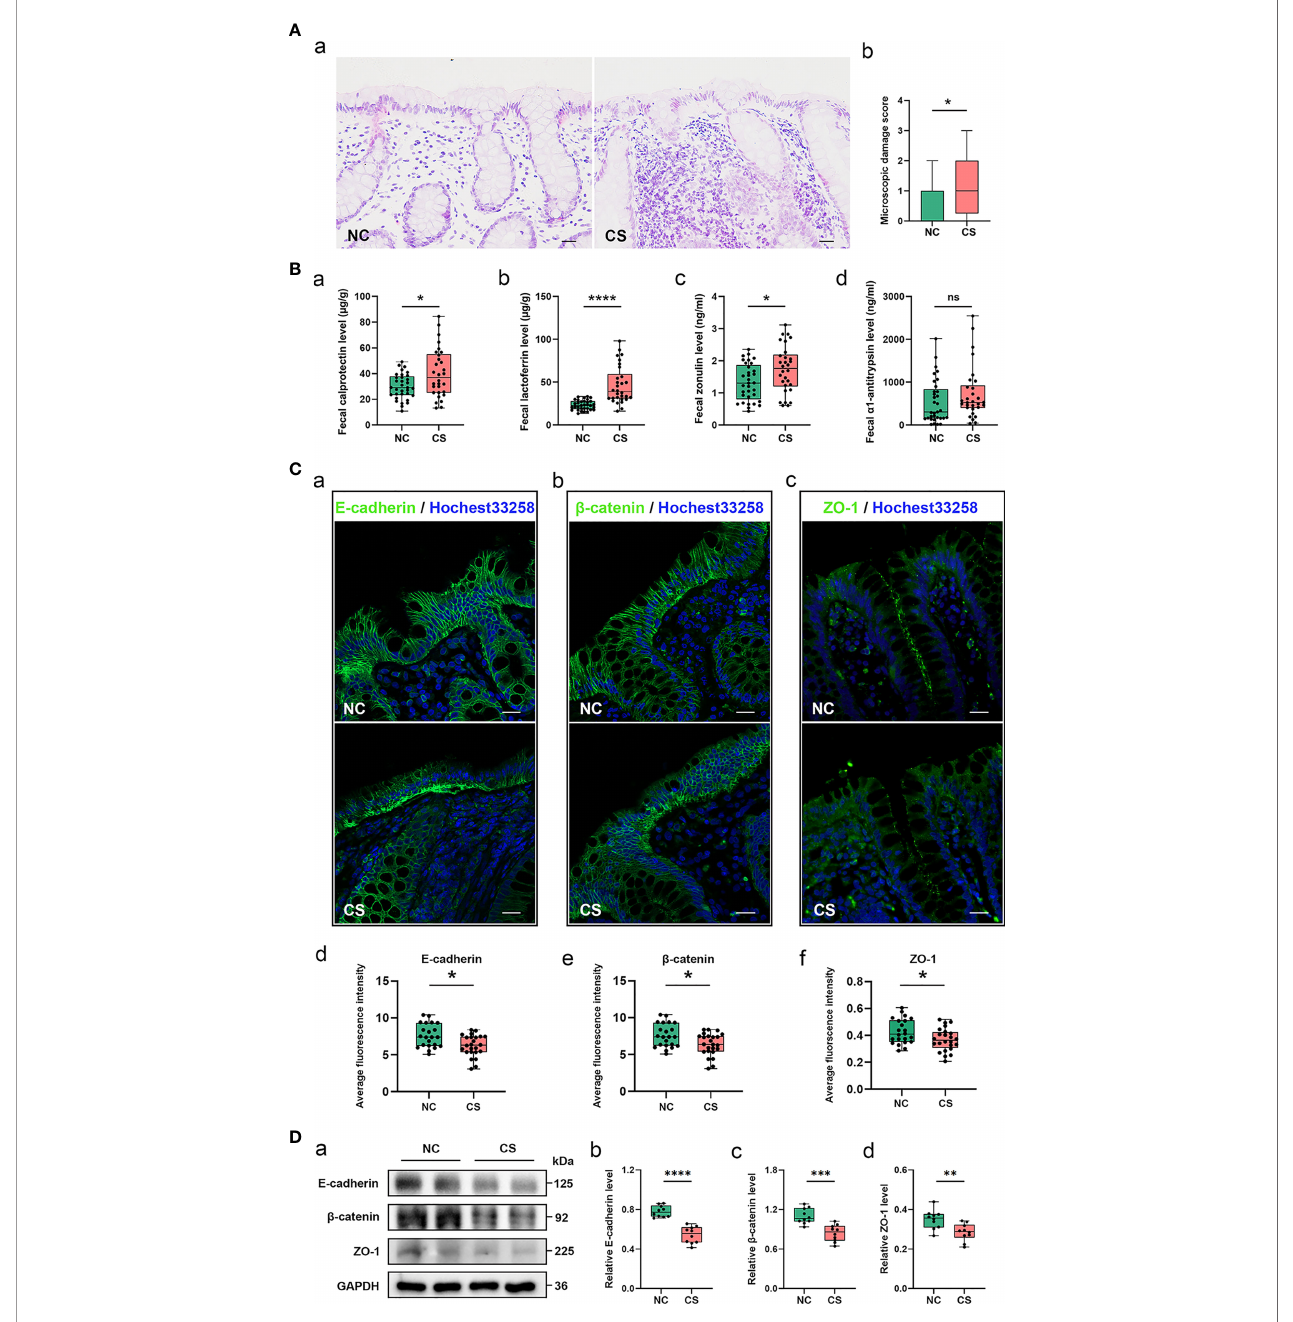
FIGURE 1 | Gut in fl ammation with increased intestinal permeability developed in CS patients. (A) Representative images of H&E staining of the colon tissue (a) . Microscopic damage score calculated after microscopic analyses of the colon sample from two groups (b) . Scale bar: 20 m m. (B) Comparison of fecal biomarker levels [calprotectin (a) , lactoferrin (b) , zonulin (c) , and a 1-antitrypsin (d) ] in CS patients and the controls. (C) Representative image and quanti fi cation of E- cadherin (a, d) , b -catenin (b, e) , and ZO-1 (c, f) in immuno fl uorescence staining. Scale bar: 20 m m. (D) Representative immunoblot images of E-cadherin, b - catenin, and ZO-1 in the colonic epithelium of subject (a) and quanti fi cations (b – d) . The loading controls (GAPDH) were run on different gels in the same experiment. n = 10; p < 0.05 indicates statistical signi fi cance (* p < 0.05, ** p < 0.01, **** p < 0.0001), and ns means p ≥ 0.05. Results are expressed as median and quartile. CS, cryptogenic